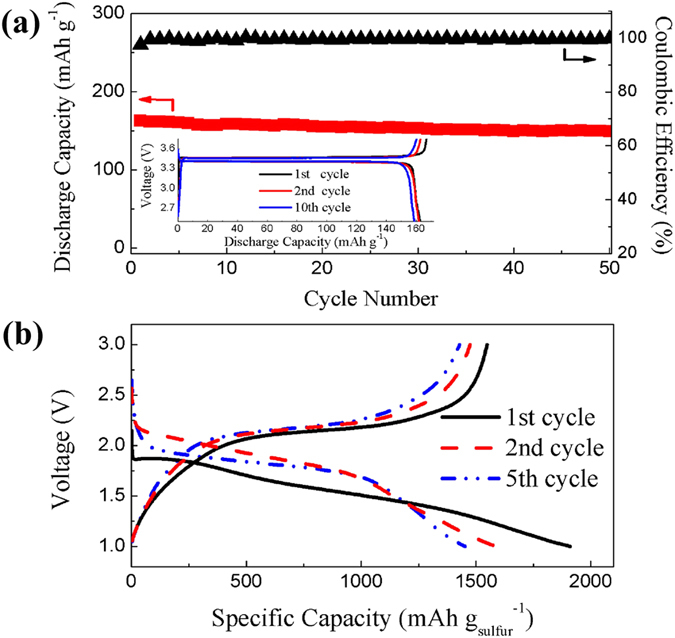
The compatibility of electrolyte with different cathodes.Cycling performance of (a) Li/LiFePO4 cell and Charge–discharge characteristics of (b) Li/Scomposite cell with DX-DME/1M LiFSI electrolyte at 0.1C.